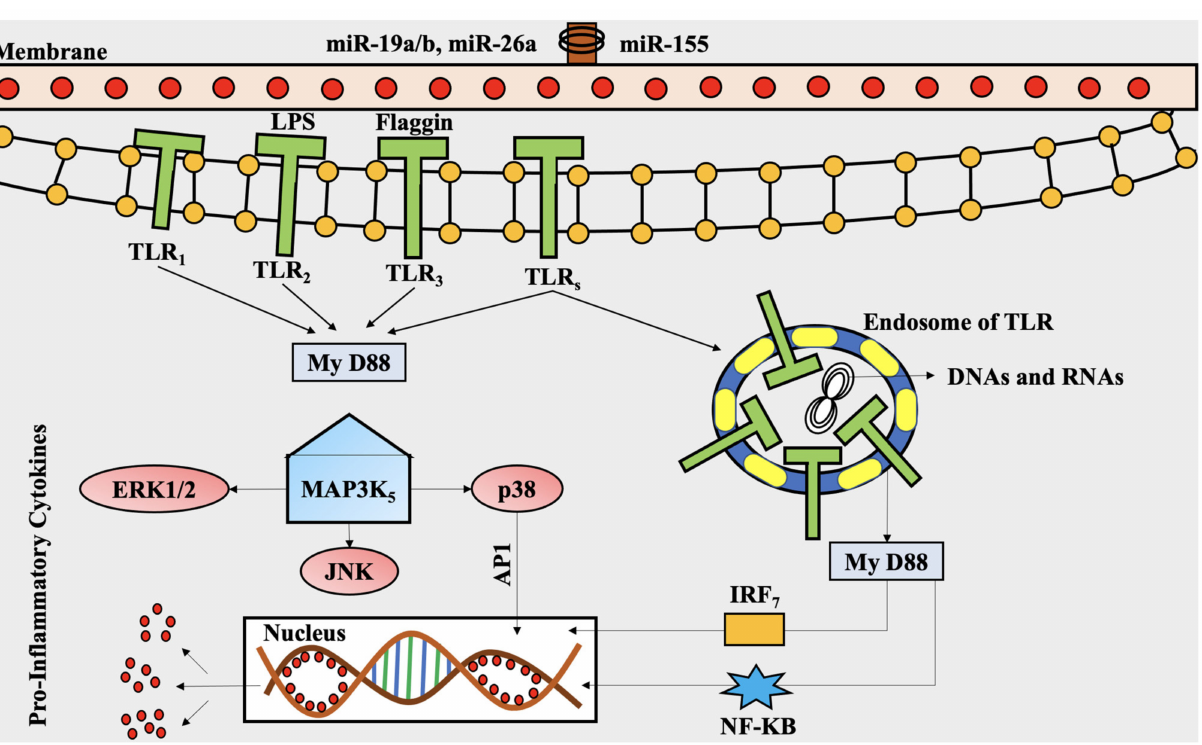
Figure 4. The involvement of numerous bioactive substances in the TLR-dependent MAPK signaling cascade in RA. The TLR receptor attracts (MyD) 88 and other related adaptor proteins are activated (ERK1/2, JNK, P38). The MyD88-dependent system controls the expression of pro-inflammatory cytokines and other immune-related genes, signaling through the MAPK pathway, which in turn leads to the activation of the transcription factor AP-1 in RA. ERK: extracellular regulated kinase; IRF: interferon regulatory transcription factor; My D88: myeloid differentiation primary response 88; TLRs: Toll-like receptors; LPSs: lipopolysaccharide receptor; MAPK: mitogen-activated protein kinase; JNK: Jun N-terminal kinases; NF- κ B: nuclear factor kappa-light-chain-enhancer of activated B cells; miR: microRNA; AP1: activator protein 1; p38: a